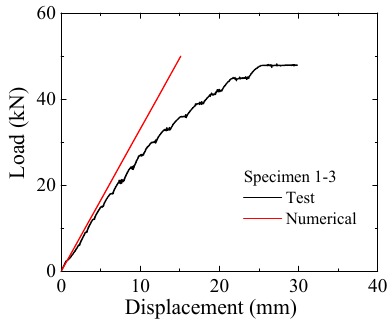
Figure 10. Numerical and test results of specimen 1-3.